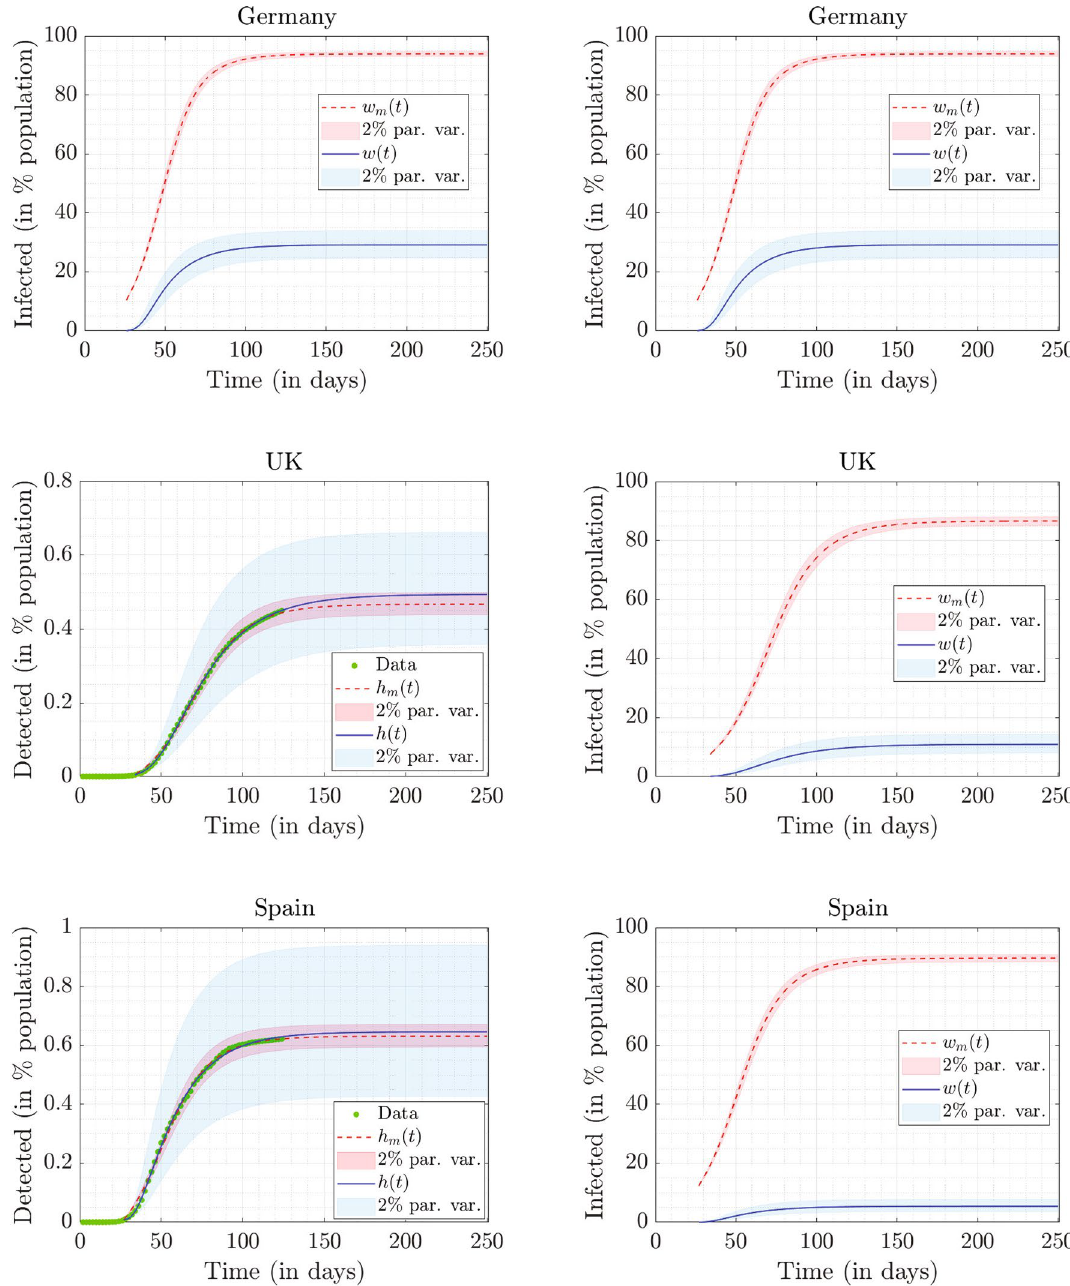
0.2206% , h ( 250 ) 0.2246% , w 250 ) 93.9666% Figure 3. Top row: Fitted results for Germany, h m ( 250 ) m ( = = = 29.1509% . Middle row: Fitted results for the UK, h 250 ) 0.4671% , h ( 250 ) 0.4934% , and w ( 250 ) m ( = = = 86.6384% and w ( 250 ) 10.9269% . Bottom row: Fitted results for Spain, h 250 ) 0.6311% , w m ( 250 ) m ( = = = 0.6456% , w 250 ) 89.6423% and w ( 250 ) 5.3903% . Data in percentage of population for detected h ( 250 ) m ( = = = cases, obtained from Worldometer, is plotted using green circles. We have plotted the data of alternate days for clarity. The fits obtained from the mean- β model are shown using dashed red curves, while those from the continuum model are shown using solid blue curves. The parameters used in the mean- β model and continuum model for obtaining the fit are shown in Tables 3 and 4, respectively. The red and blue shaded bands in all 2% variations in the parameters in the mean- β model and the continuum model, the figures correspond to ±